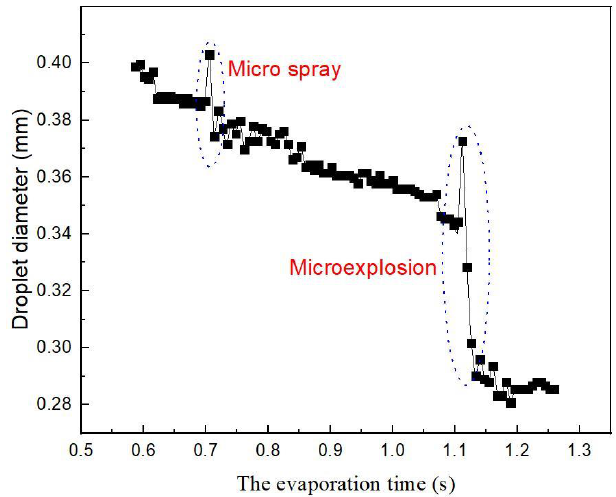
Figure 6. The experimental diameter variation of bi-component droplets with the ethanol mass fraction of 0.8 in the hot air of 573 K.